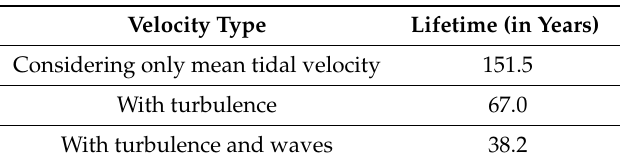
Table 7. Lifetime Values.